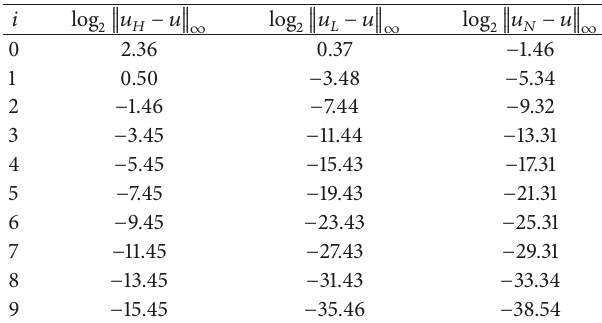
Table 1: Results for 𝐷 𝑖 = [−2 −𝑖 ,2 −𝑖 ] × [−2 −𝑖 ,2 −𝑖 ] for 𝑖 = 0,9